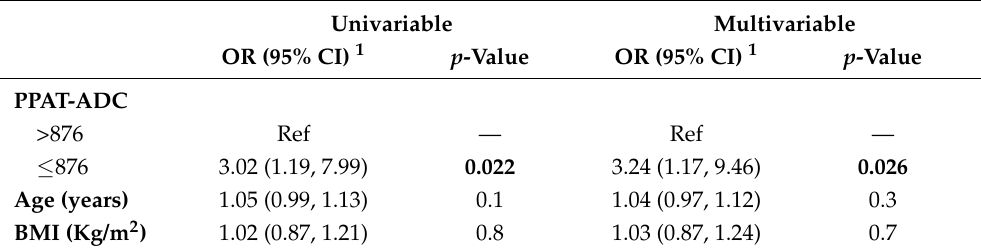
Table 4. Logistic regression analyses tested the association between peri-prostatic adipose tissue (PPAT)—apparent diffusion coefficient (ADC) and intermediate-high risk prostate cancer according to D’Amico